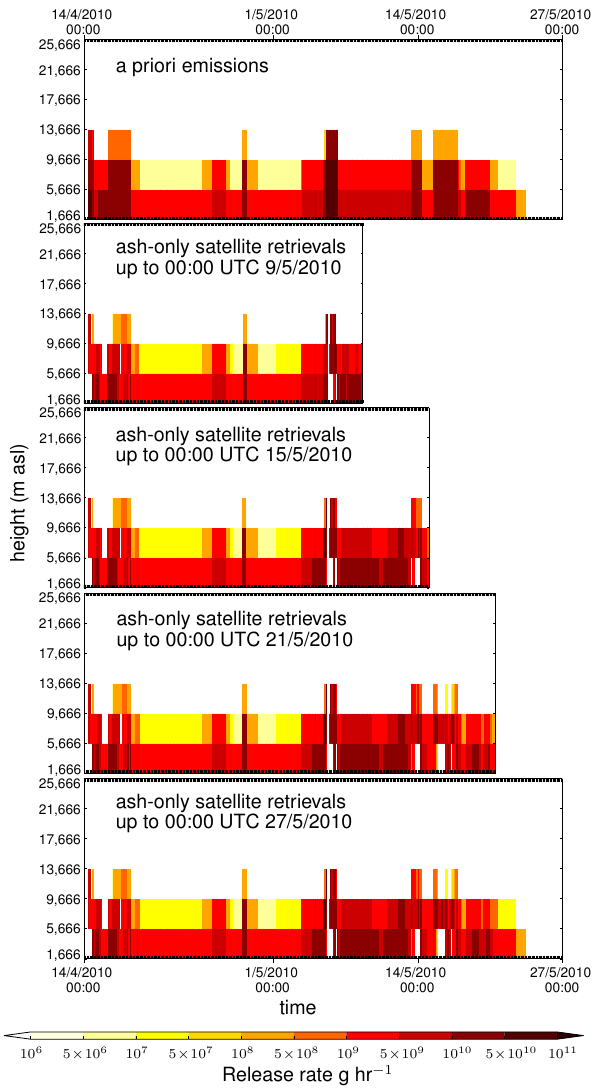
Figure 3. Emission profiles (g hr − 1 ) estimated by InTEM for the 2010 Eyjafjallajökull eruption. The a priori emissions and the inversion emission profiles using the ash-only satellite retrievals available up to various cut-off times are shown. Each inversion emission profile uses six more days of satellite retrievals than the previous